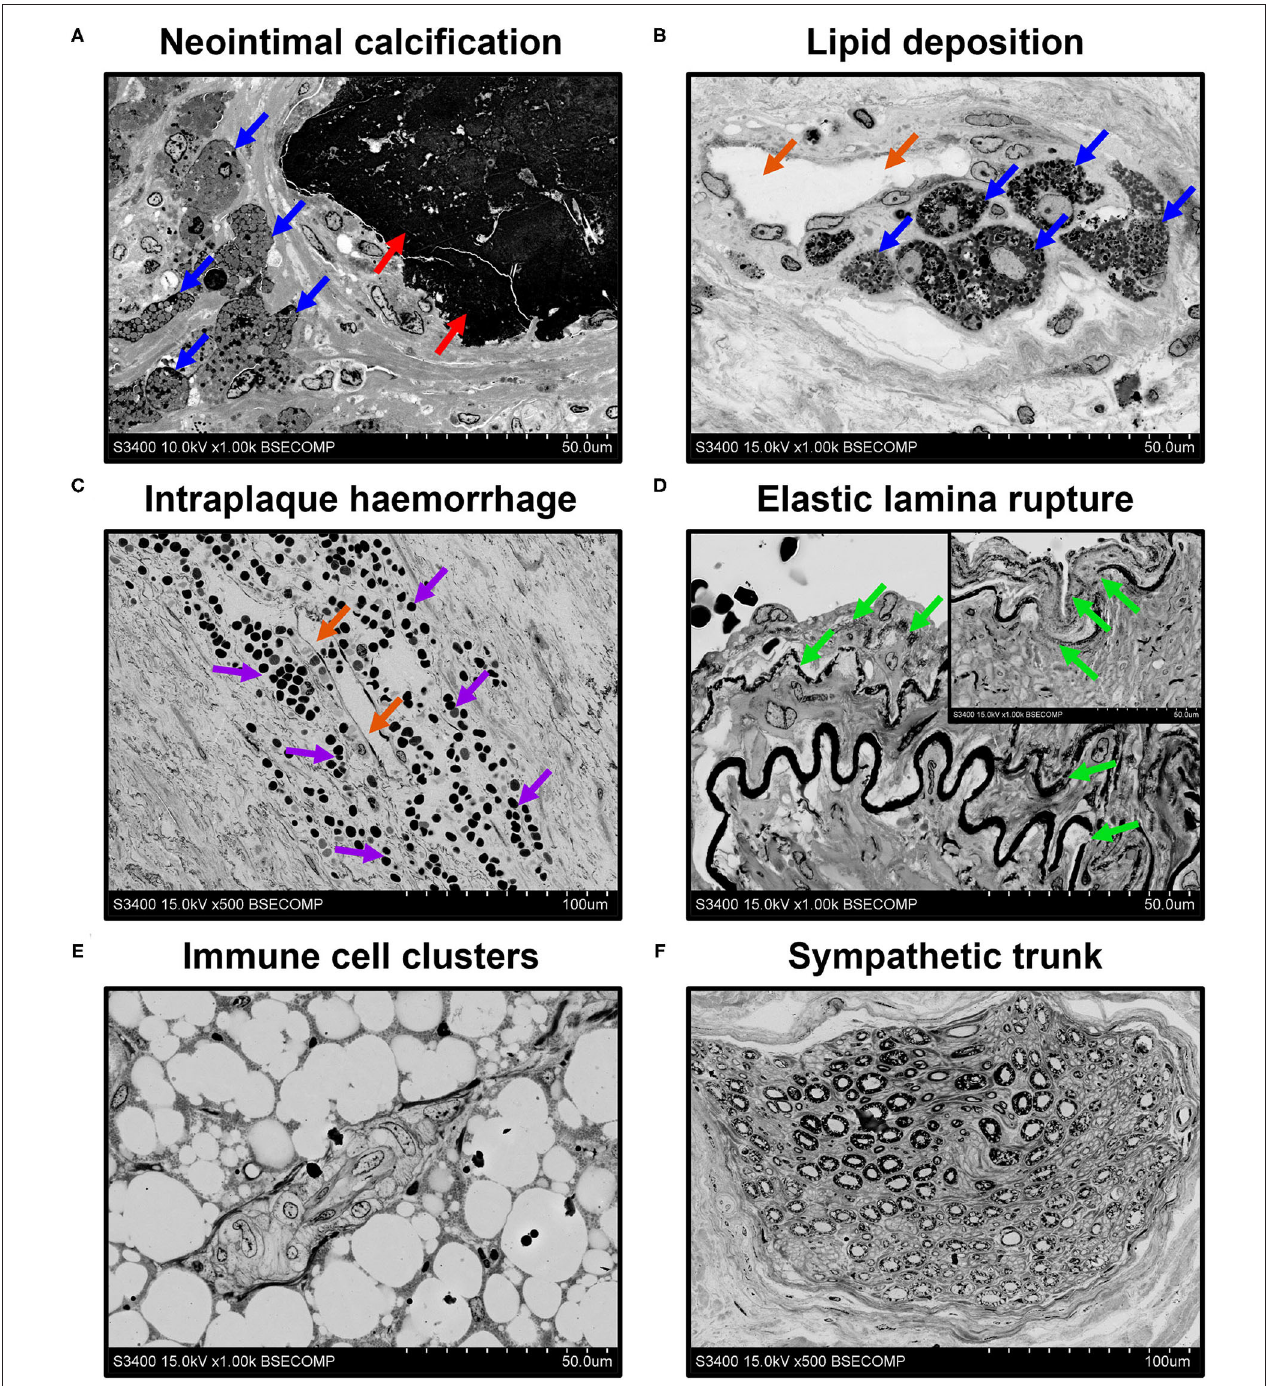
FIGURE 6 | EM-BSEM imaging of cardiovascular pathology. Note the abundance of (A,B) foam cells (indicated by blue arrows) and (C) red blood cells (indicated by violet arrows) near the calcium deposit (indicated by red arrows) and neovessels (indicated by orange arrows) within the carotid plaque. (D) Also note the age-dependent degradation of the elastic laminae (indicated by green arrows) of the left internal mammary artery excised for coronary artery bypass graft surgery purposes. Note the vascular smooth muscle cells between the elastic laminae and the traceable contours of the internal elastic lamina repeating that of the following elastic laminae. The insert in the upper-right corner indicates the visible decomposition of two sequential elastic laminae. (E) Immune cell clusters frequent in the adventitia and perivascular adipose tissue of rat descending aorta undergo hyperplasia at inflammation and might represent a valuable marker of immune response but should be clearly distinguished from (F) a sympathetic trunk. A magnification × 1,000 (scale bar: 50 µ m) for all images, except, that of intraplaque haemorrhage and sympathetic trunk (x500 magnification, scale bar: 100 µ m). The accelerating voltage was 15 kV for all images excepting that of neointimal calcification (10 kV).